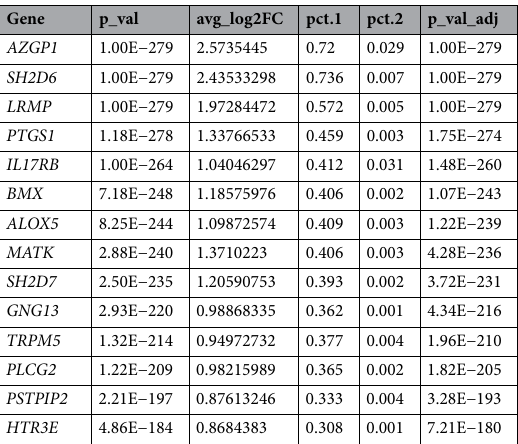
Table 1. 11q23.1 trans-eQTL targets identified as cluster 11 markers. Markers calculated using MAST 49 . Avg_ log2FC average log2 fold change between cluster 11 and all other clusters, Pct1 proportion of gene expression in cluster 11, Pct2 proportion of expression in non-cluster 11, p_val_adj FDR-corrected